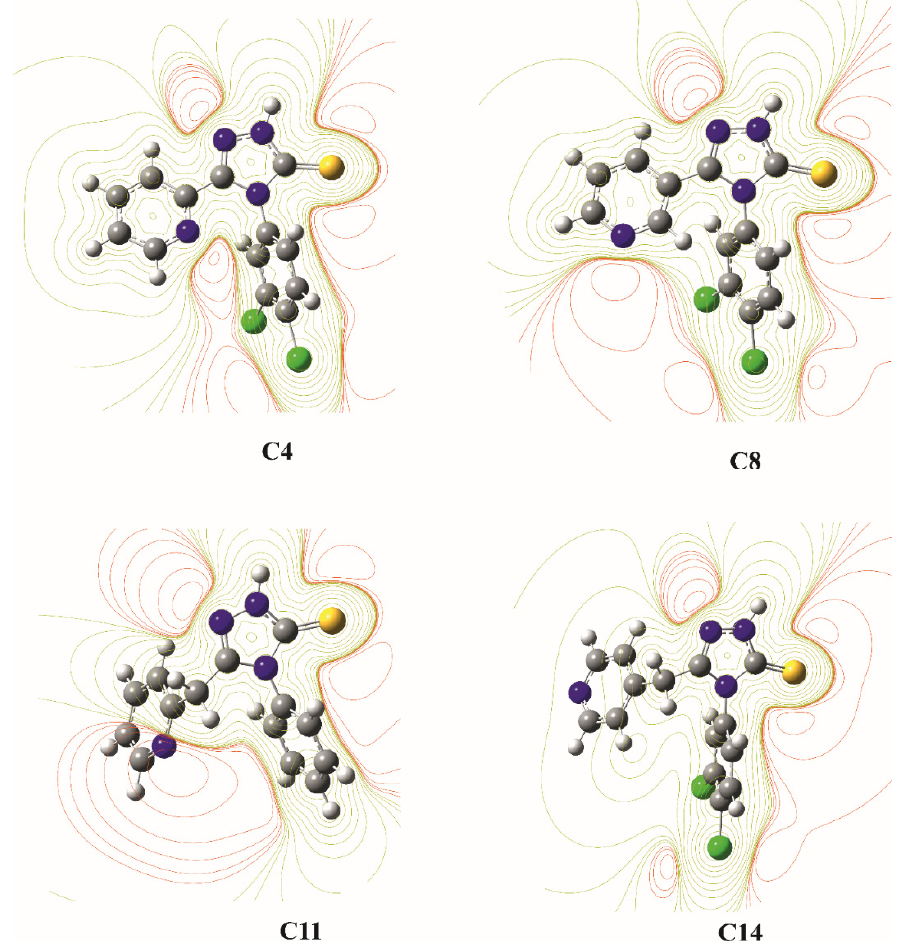
Figure 3. The contour maps of molecular electrostatic potential for compounds C4, C8, C11, and C14 in the plane of the 1,2,4-triazole ring; the red lines represent regions with the negative electrostatic potential and yellow lines represent regions with the positive electrostatic potential.